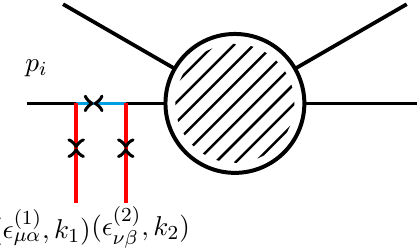
Figure 4 . Feynman diagram for double soft gravitini | II.